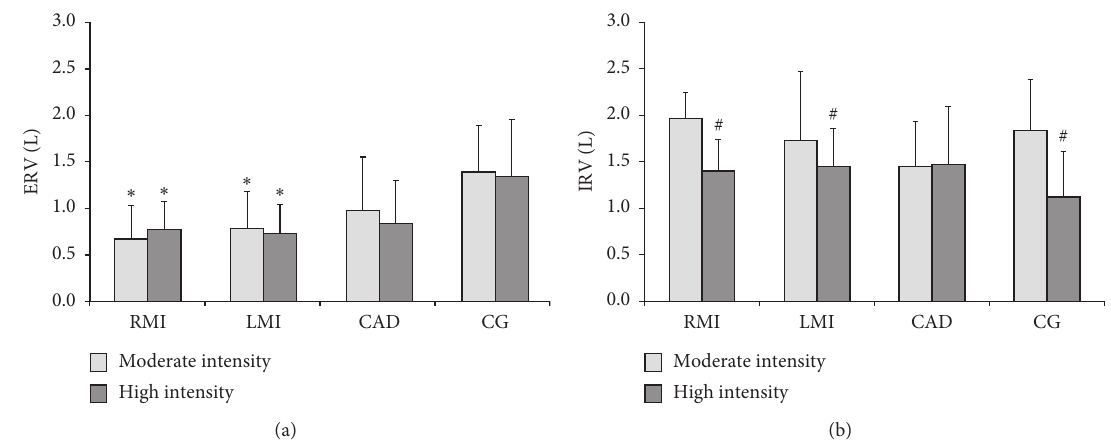
Figure 3: Expiratory reserve volume (a) and inspiratory reserve volume (b) at moderate and high intensity exercise. Data are presented as mean ± SD. EVR, expiratory volume reserve; IVR, inspiratory volume reserve; RMI, recent myocardial infarction group; LMI, late myocardial infarction group; CAD, stable coronary artery disease group; CG, control group. ∗ Difference in relation to CG in the same intensity. # Difference in relation to moderate intensity exercise ( p < 0 . 05). Two-way ANOVA (Tukey post hoc) was